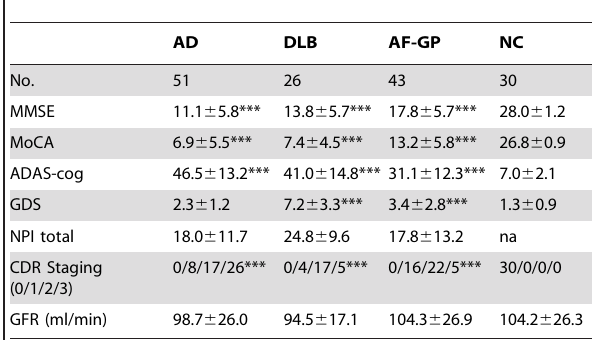
Table 2. Clinical